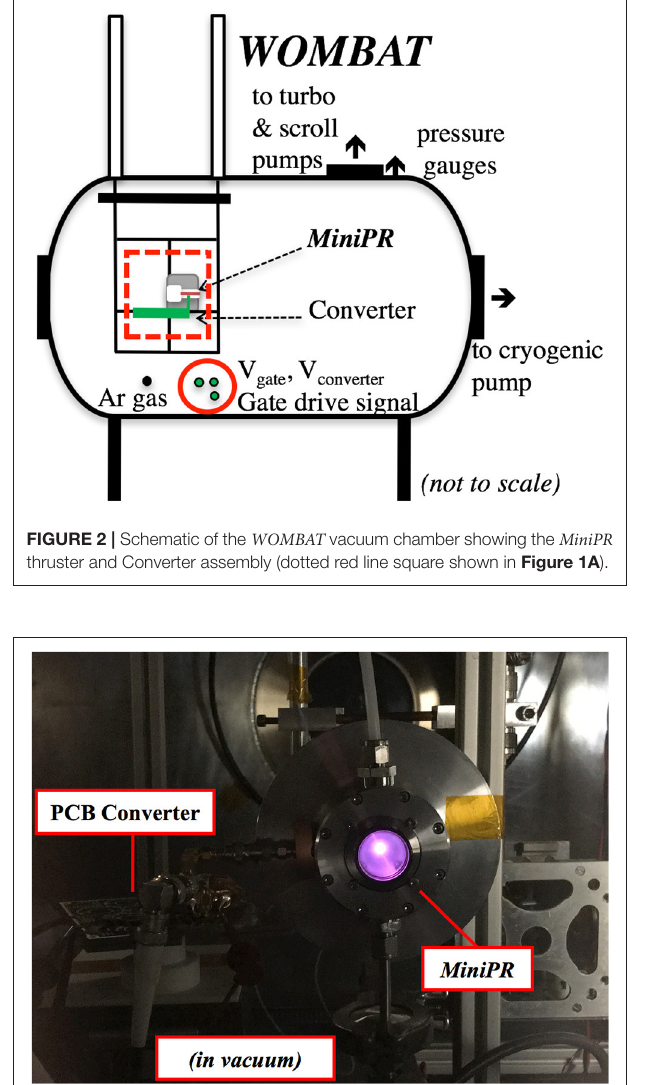
be shielded with a copper layer without inducing high